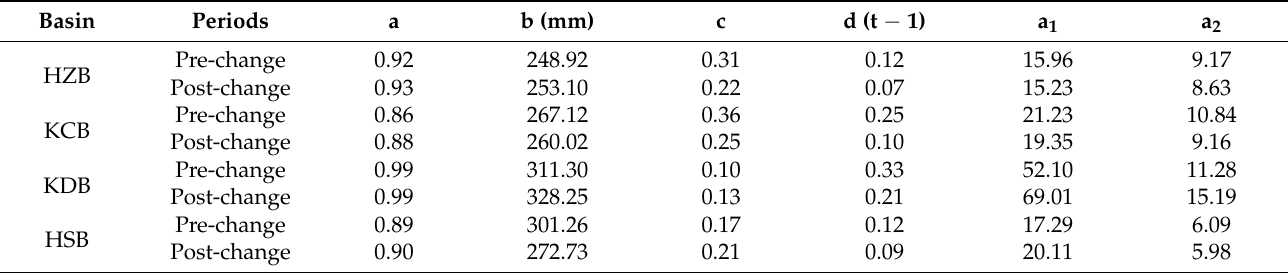
Figure A6. Spatial (a) and temporal (b) Change trends in NDVI values derived from MODIS for the four basins during 2013 − 2021. p (browning) and p (greening) are the significance of the decrease and increase in NDVI values examined by the MK test. p values are divided into three levels: p < 0.01, 0.01 < p < 0.05, and p > 0.05. Table A1. Optimized parameters of abcd model.